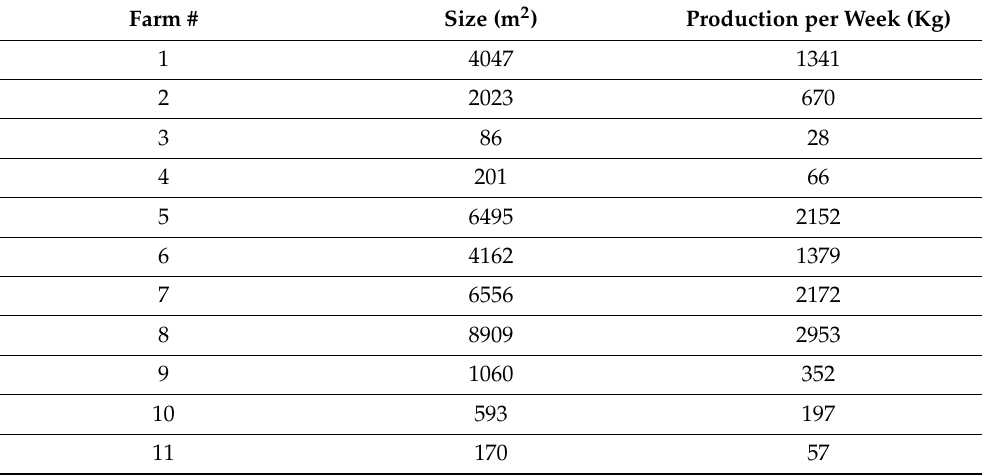
Table 3. Farm size and weekly production of vegetables at each urban farm location. Farm # Size (m 2 ) Production per Week (Kg) 1 4047